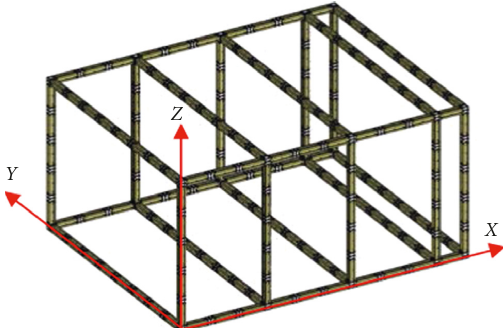
Figure 19: Structural scheme for a diaphanous volume.